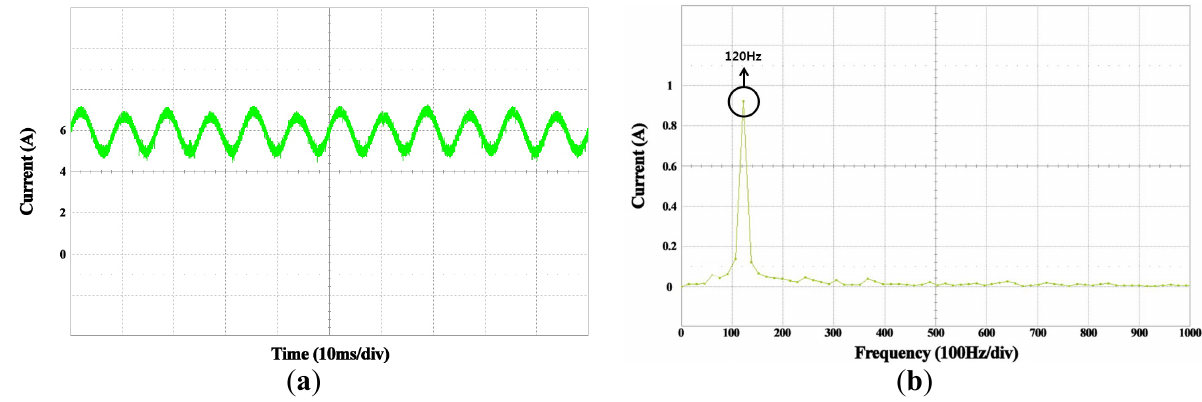
Figure 22. Magnitude of PV current without compensation. ( a ) Time domain; ( b ) frequency domain.